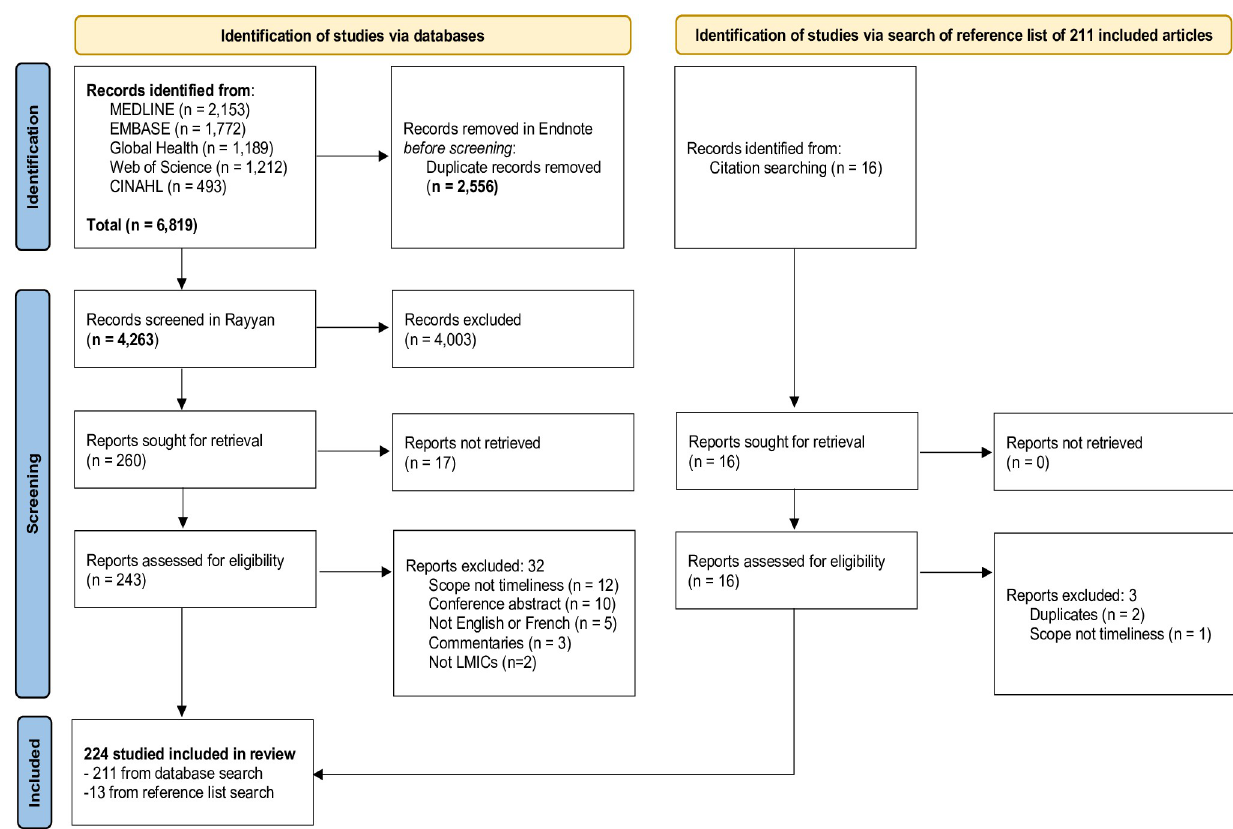
Fig 1. Flowchart showing study identification, screening, and selection